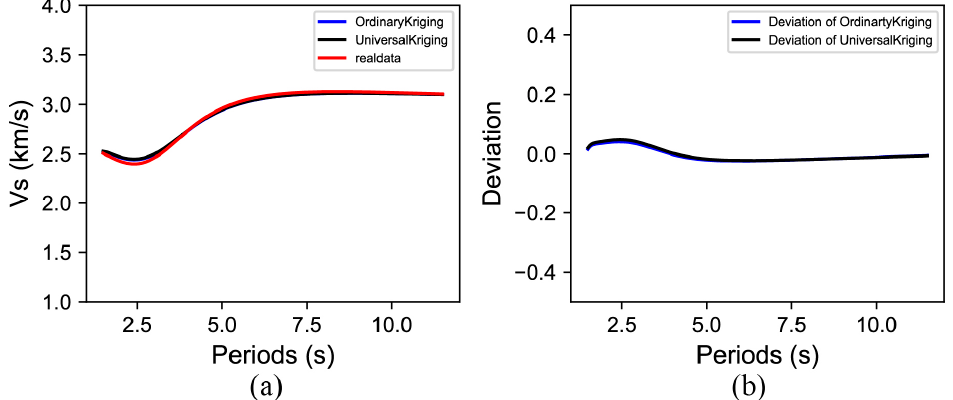
Figure A8. Comparison of dispersion curve interpolation results (128.18° E, 42.27° N ). The blue curve indicates the ordinary kriging results, while the black curve indicates those of universal kriging: ( a ) Comparison of the dispersion curves; and ( b ) deviation of the OK (blue) or UK (black) results.